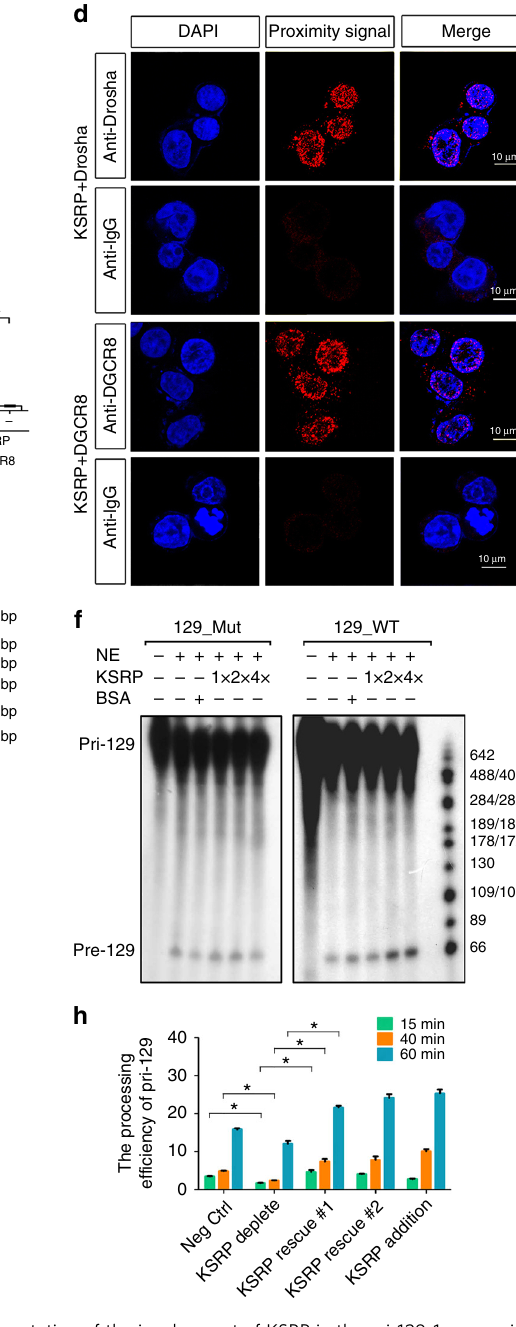
Fig. 6 KSRP promotes the processing of pri-129-1 in vitro. a Schematic representation of the involvement of KSRP in the pri-129-1 processing model. b As shown in the co-IP analysis, KSRP interacts with the Drosha-DGCR8 complex in THP-1 cells in an RNA-independent manner. This experiment was performed by incubating the KSRP immunoprecipitates with or without RNAse A (0.1 mg/mL) at 37 °C for 20 min. c Agarose gel electrophoresis showing the results of the RIP-PCR of pri-129-1, pri-23b and pri-let7a was performed by immunoprecipitating the complexes in KSRP knockdown or control 293T cells with Drosha and DGCR8 antibodies. d Representative images for in situ proximity ligation assay (PLA) of KSRP with Drosha or DGCR8 in 293T cells (Scale bar, 10 μ m; Original magni fi cation, 630×). e Quanti fi cation of PLA results ( n ≥ 3; cell numbers > 100 per experiment) were shown. f In vitro pri-129-1 processing reactions used isotope-labeled wild-type pri-129-1 (129_WT) or pri-129-1 with KSRP-binding site mutants (all four sites mutant, 129_Mut) as the substrate and were then pre-incubated with HeLa NEs and various amounts of puri fi ed KSRP protein, as described in the Methods. g Rescue of the KSRP levels in NEs after KSRP depletion with an anti-KSRP antibody further promotes pri-129-1 processing in the in vitro processing assay, as indicated in f . h Quantitation of the in vitro processing assay shown in g . Similar signi fi cant differences ( p -value < 0.05, two-tailed Student ’ s t -test) were obtained between the KSRP depletion group and the KSRP rescue #1 or #2 groups. Three technical replicates from a single experiment. Data are shown as means ± s.d. *** P < 0.001, Student ’ s t